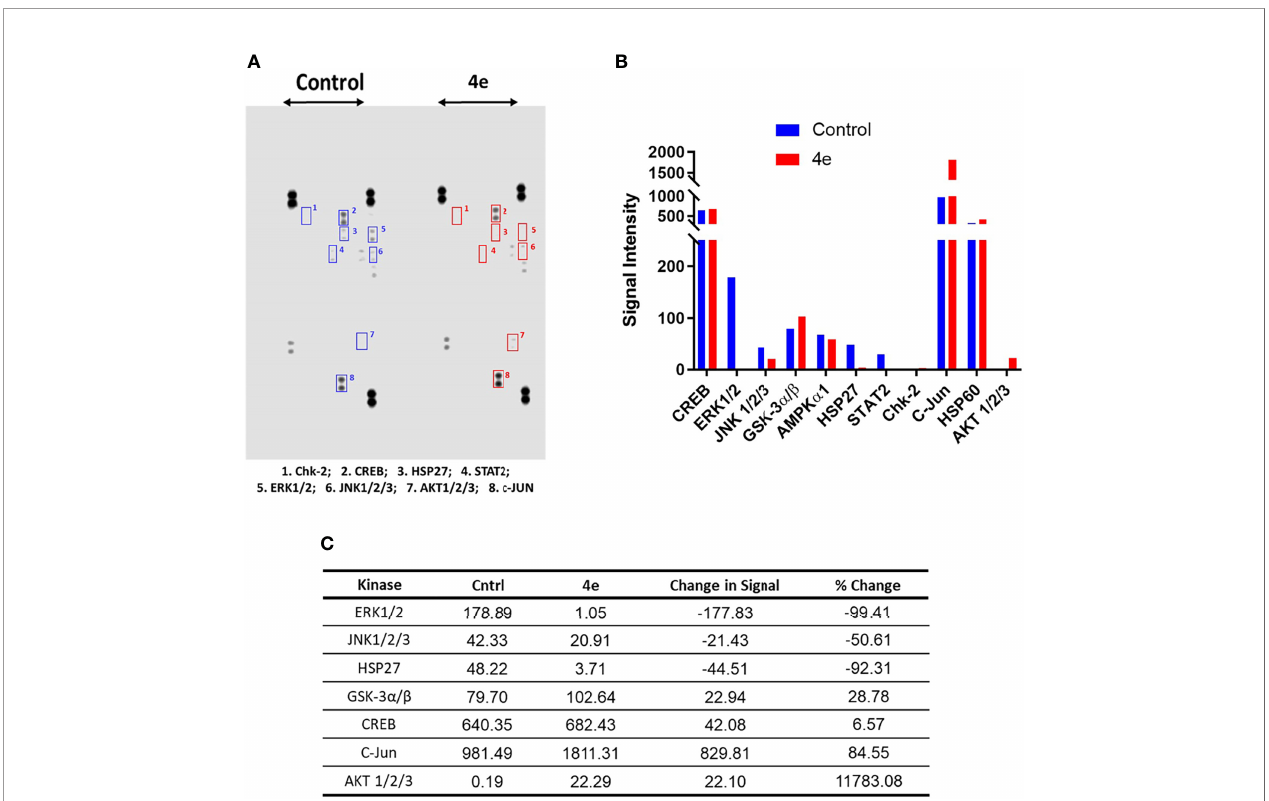
FIGURE 8 | Phosphokinase YK/STK proteome pro fi le of 4e in HL60 cell line. (A) Blot scanning of detected phosphokinase proteins captured on nitrocellulose membranes pre-spotted with different antibodies for control and compound-treated HL60 cell lysates. ( B ) Bar graph quantifying the variations in YK/STK phosphokinase signals upon 4e exposure (red bars) compared to the untreated control (blue bars). A fi le containing all phospho-kinase signal intensities can be found in Supplementary Material . (C) Difference in the kinase signals between treated and untreated